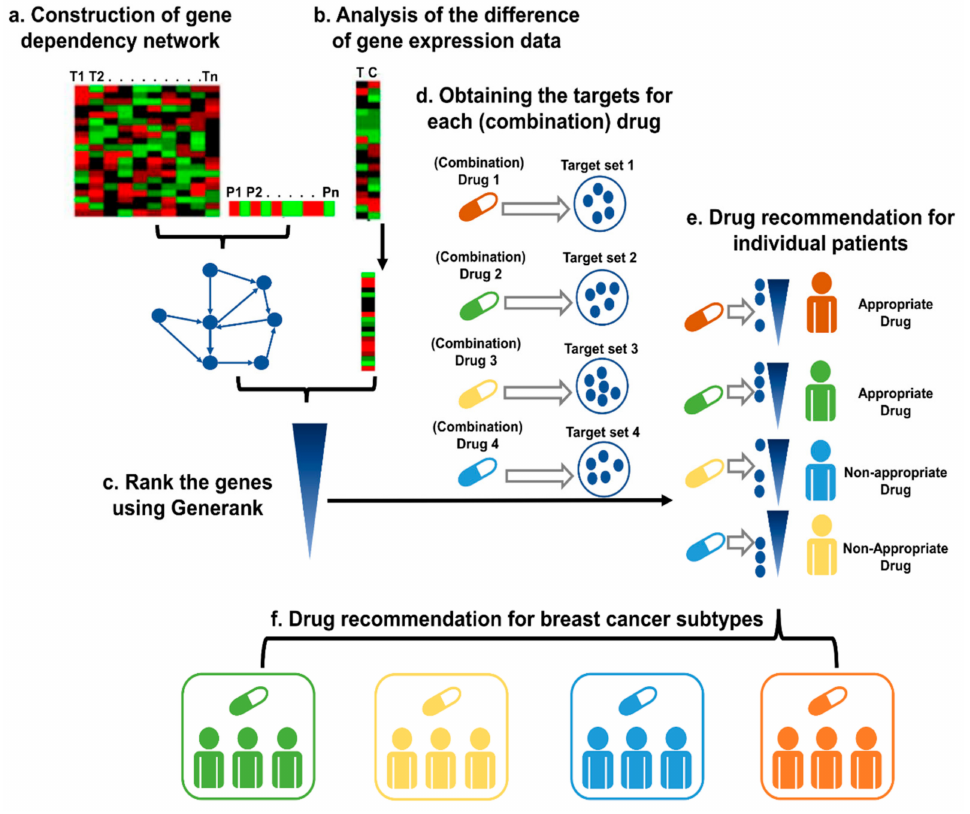
Figure 1. The pipeline for precision drug discovery. ( a ) Construction of the gene dependency network based on the gene expression data and prognostic information of the cancer patients. ( b ) The difference in gene expression levels between cancer tissue and control tissue, as indicated by the fold-change. ( c ) Based on the gene dependency network and the fold-changes of the genes of the patient, GeneRank was applied to rank the genes. ( d ) Identification of the targets for the candidate (combination) drugs. ( e ) For each drug, the Kolmogorov–Smirnov test was applied to test whether the targets were enriched among the top-ranked genes with our method. A drug is recommended as a suitable therapy if the drug targets the important genes of the patient. ( f ) The candidate (combination) drugs were defined as an appropriate therapy for a specific subtype if the effective rate in the subtype was significantly higher than that in all patients, which was evaluated with a binomial